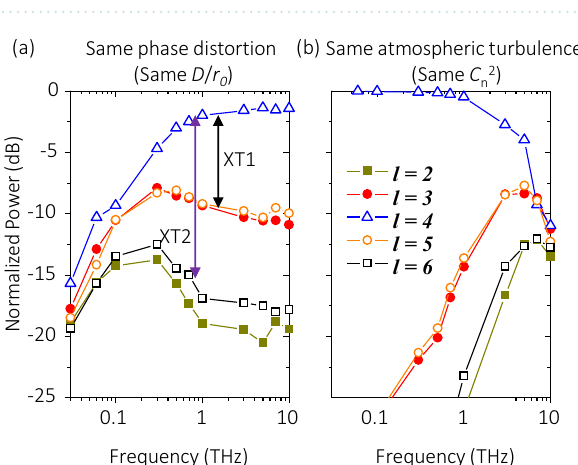
Figure 3. Normalized power distribution on different OAM modes when transmitting OAM + 4 with the same beam waist w0 = 1 m through a 1-km link. Parameters are set as ( a ) C 2 ( b ) C n = 1 × 10 –11 m -2/3 , f = 1 THz. A single OAM + 4 beam is transmitted at the transmitter side, and the power distribution on OAM + 2 to + 6 are simulated at the receiver side. The power on OAM + 4 decreases by ~ 12 dB in ( b ), which could be due to the turbulence-induced power leakage from OAM + 4 to other OAM modes.